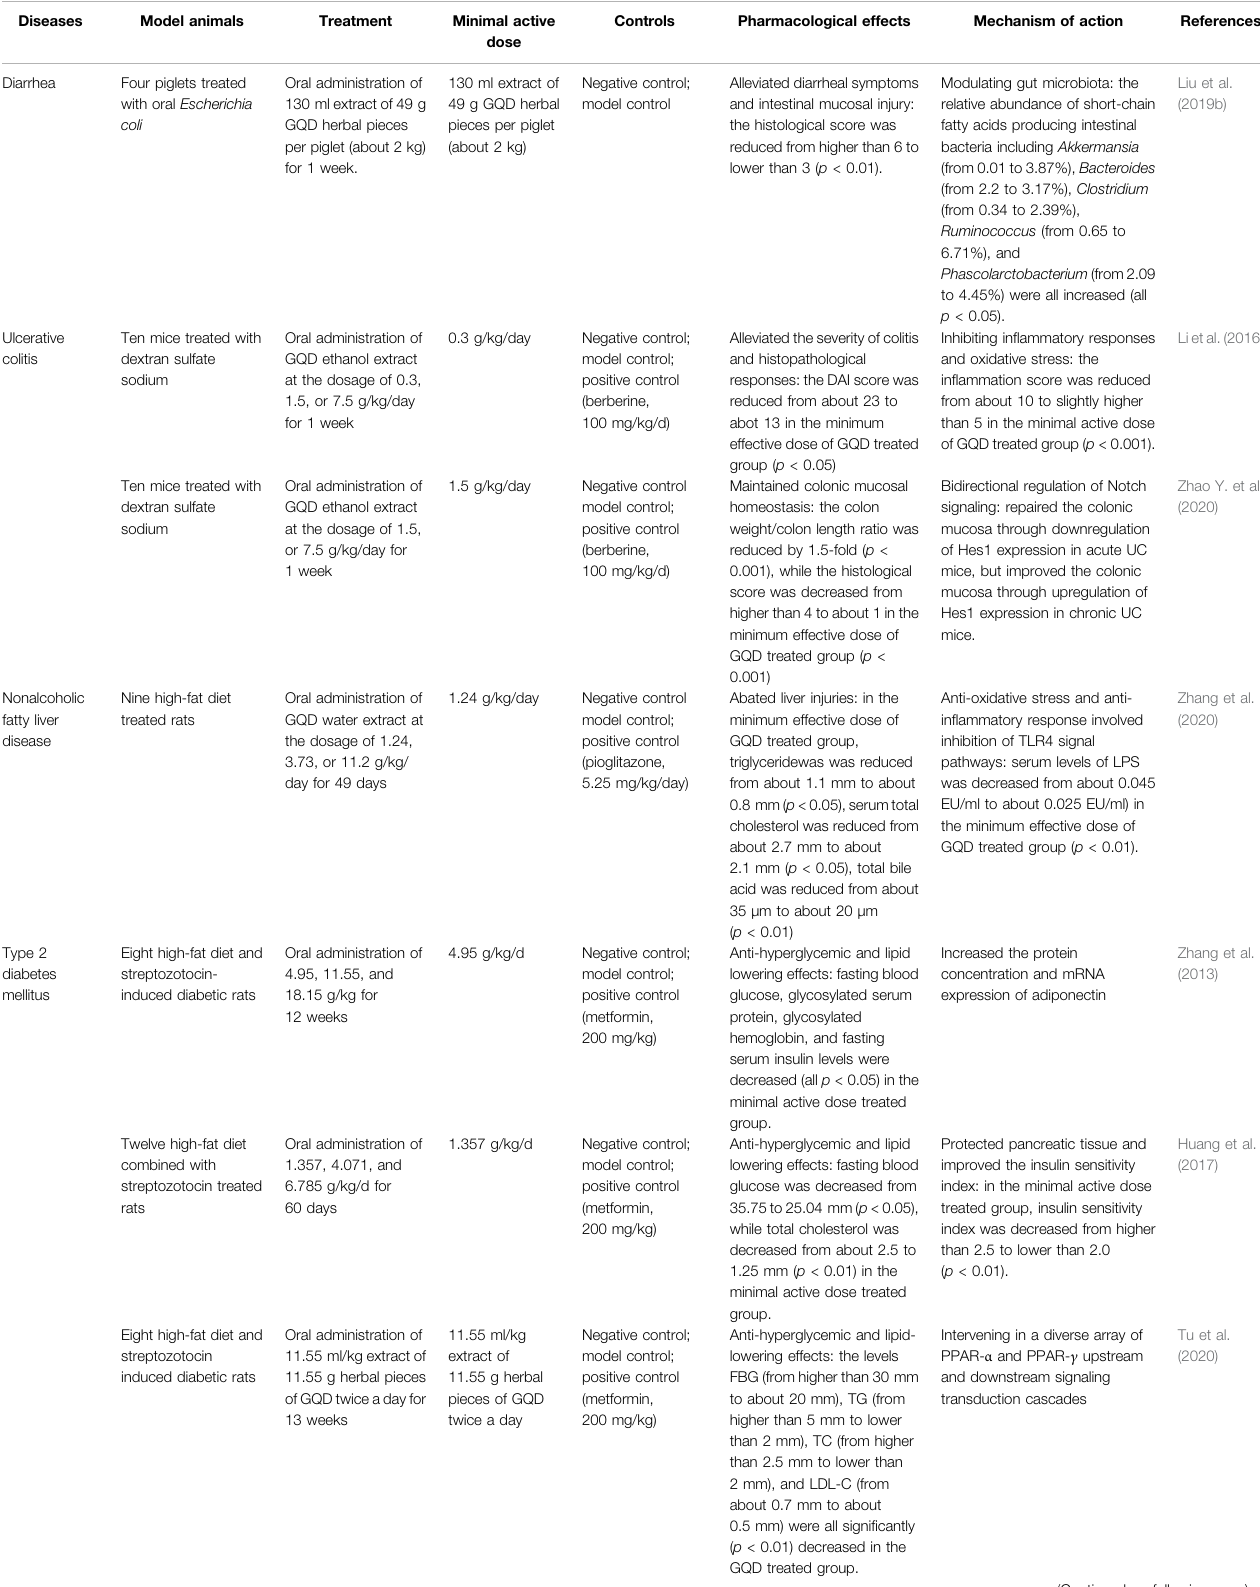
TABLE 2 | Studies on the pharmacological effects of Gegen- Qinlian decoction (GQD) in model